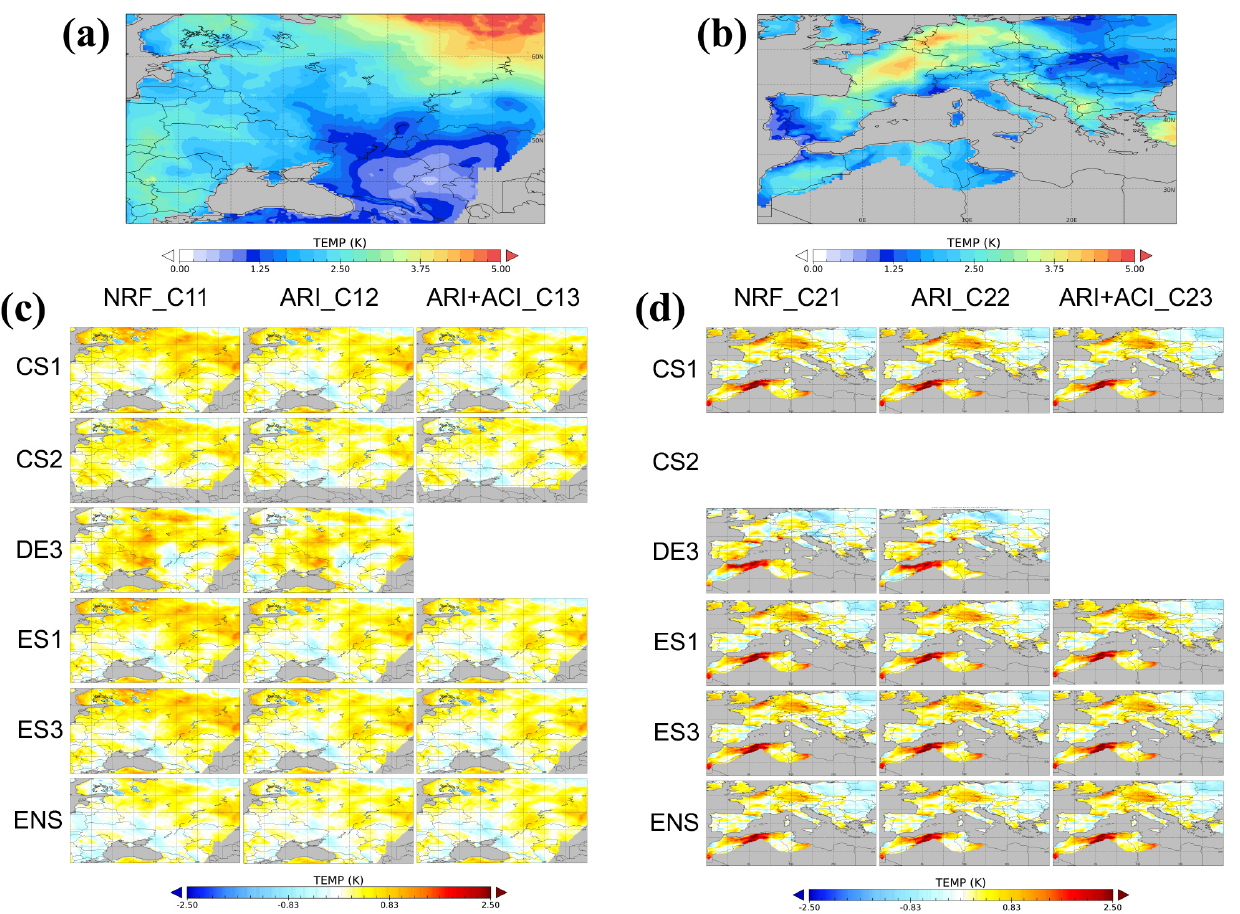
Figure 9. Standard deviation (SD) of the mean temperature (TEMP) for the fire (a) and dust (b) episodes, as derived from the E-OBS database (in K). The panels below represent the bias for the standard deviation of the fires (c) and dust (d) episodes of each simulation with respect to the E-OBS